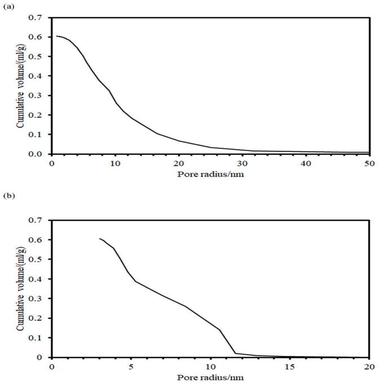
BJH pore size distributions obtained (with hemispherical meniscus geometry in Kelvin equation) from adsorption (a) and desorption (b) isotherms